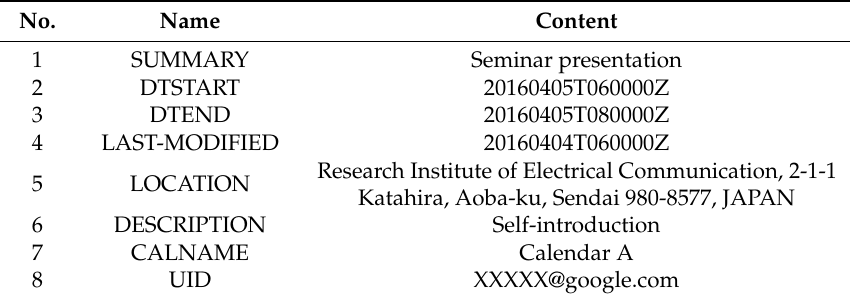
Table 2. Example of metadata that can be acquired (seminar